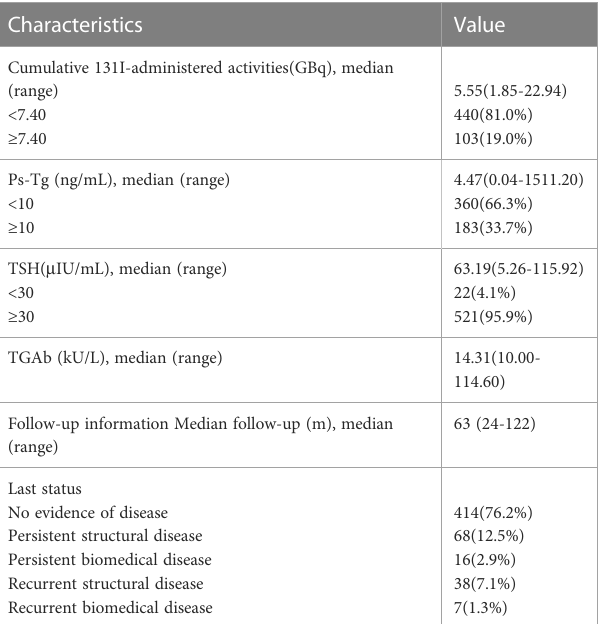
TABLE 1 Characteristics of the study patients (n = 543).